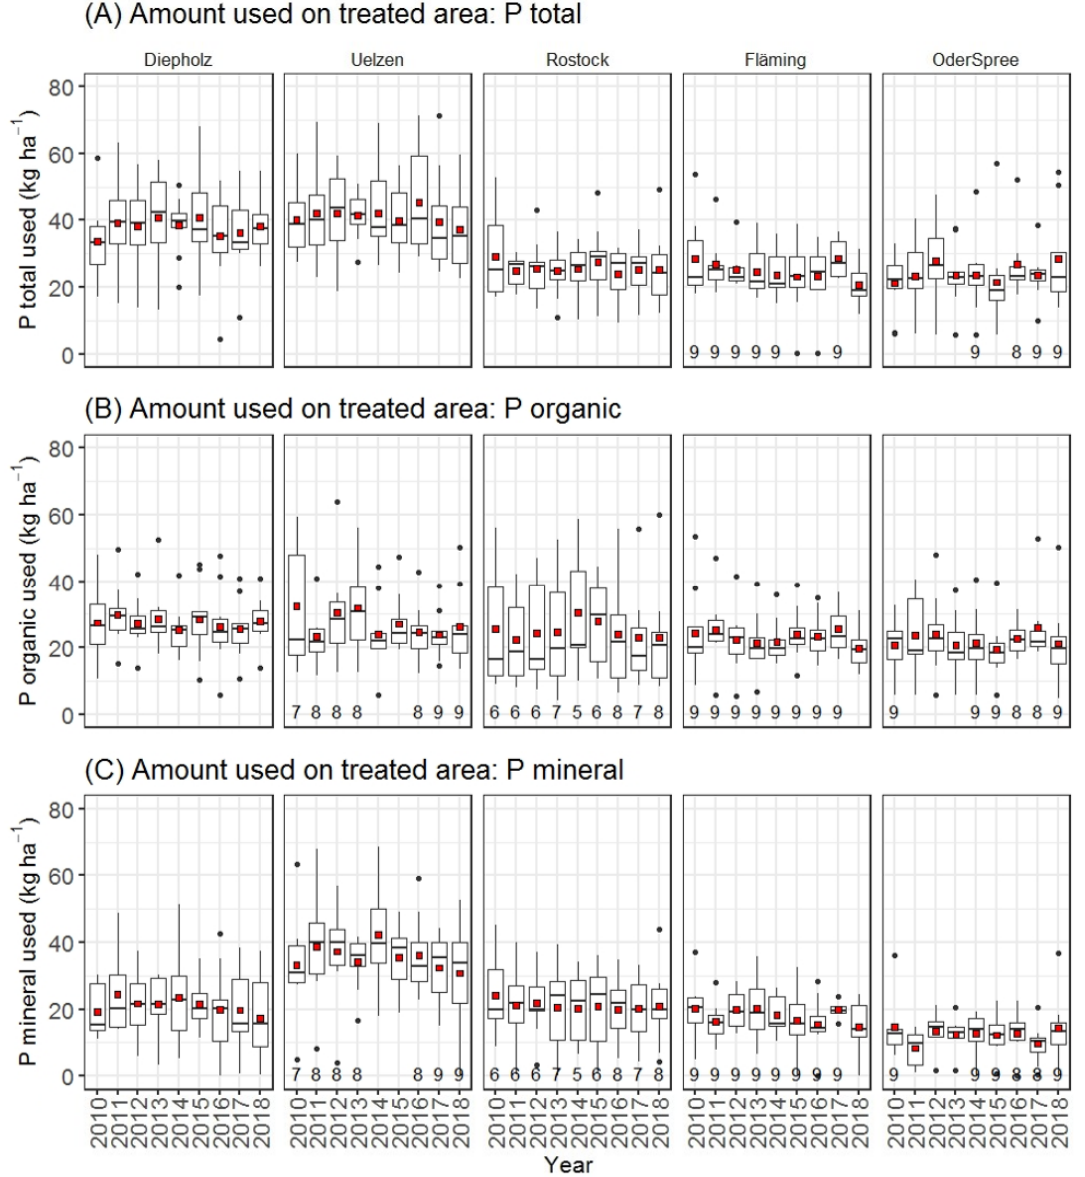
Figure 5. Amount of P used only on treated fields from 2010 until 2018 in the regions of Diepholz, Uelzen, Rostock, Fläming and Oder-Spree. ( A ) The P total, ( B ) P organic and ( C ) P mineral. Each farm contributes one value every year. N is displayed if <10 and means that some farms did not apply P in some years. The red square marks the mean value. Numbers are given in Appendix C (Table A3).